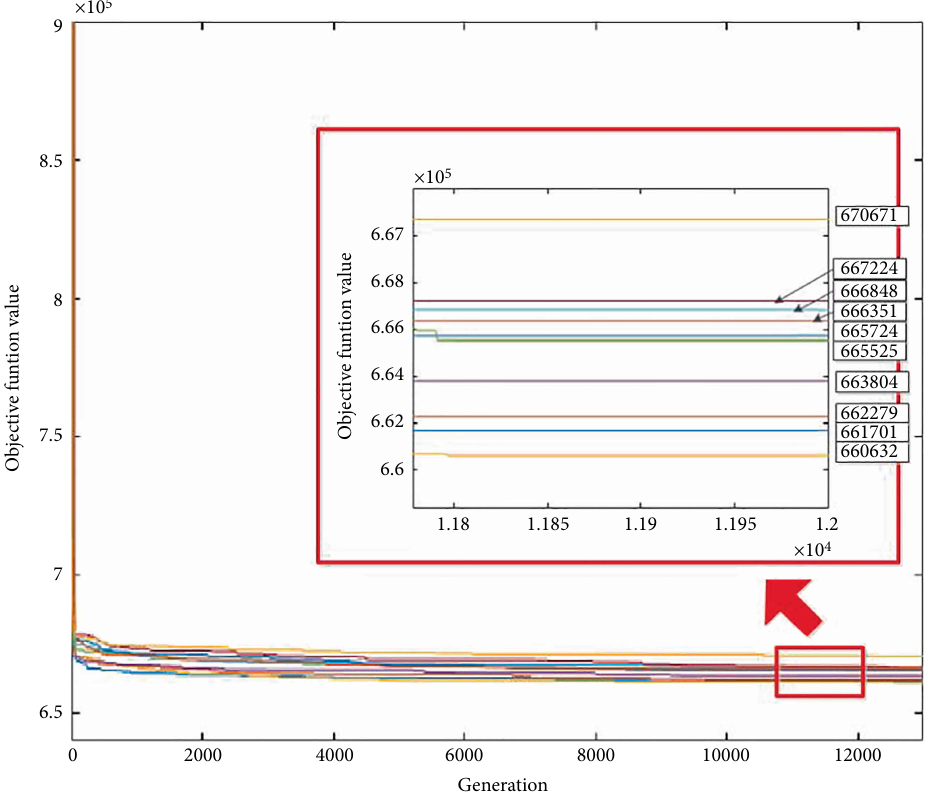
Figure 5: 10 Trials of the improved genetic